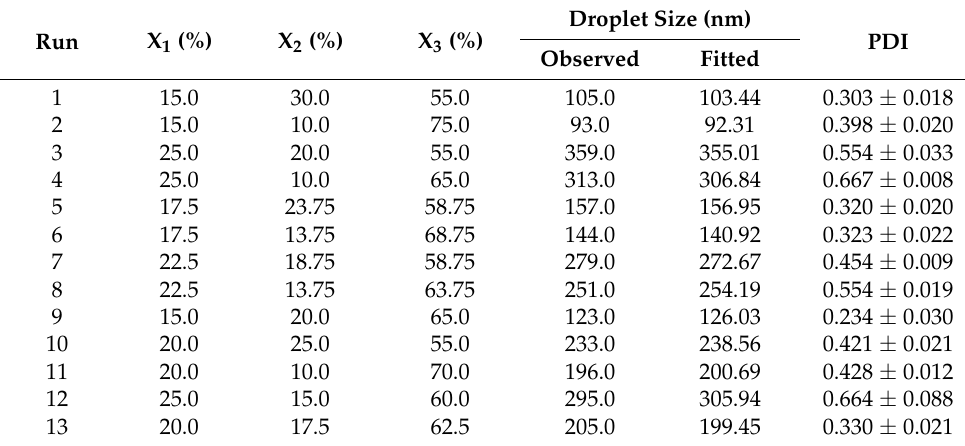
Table 1. Composition and droplet size of the studied SNEDDS formulations according to the extreme vertices mixture